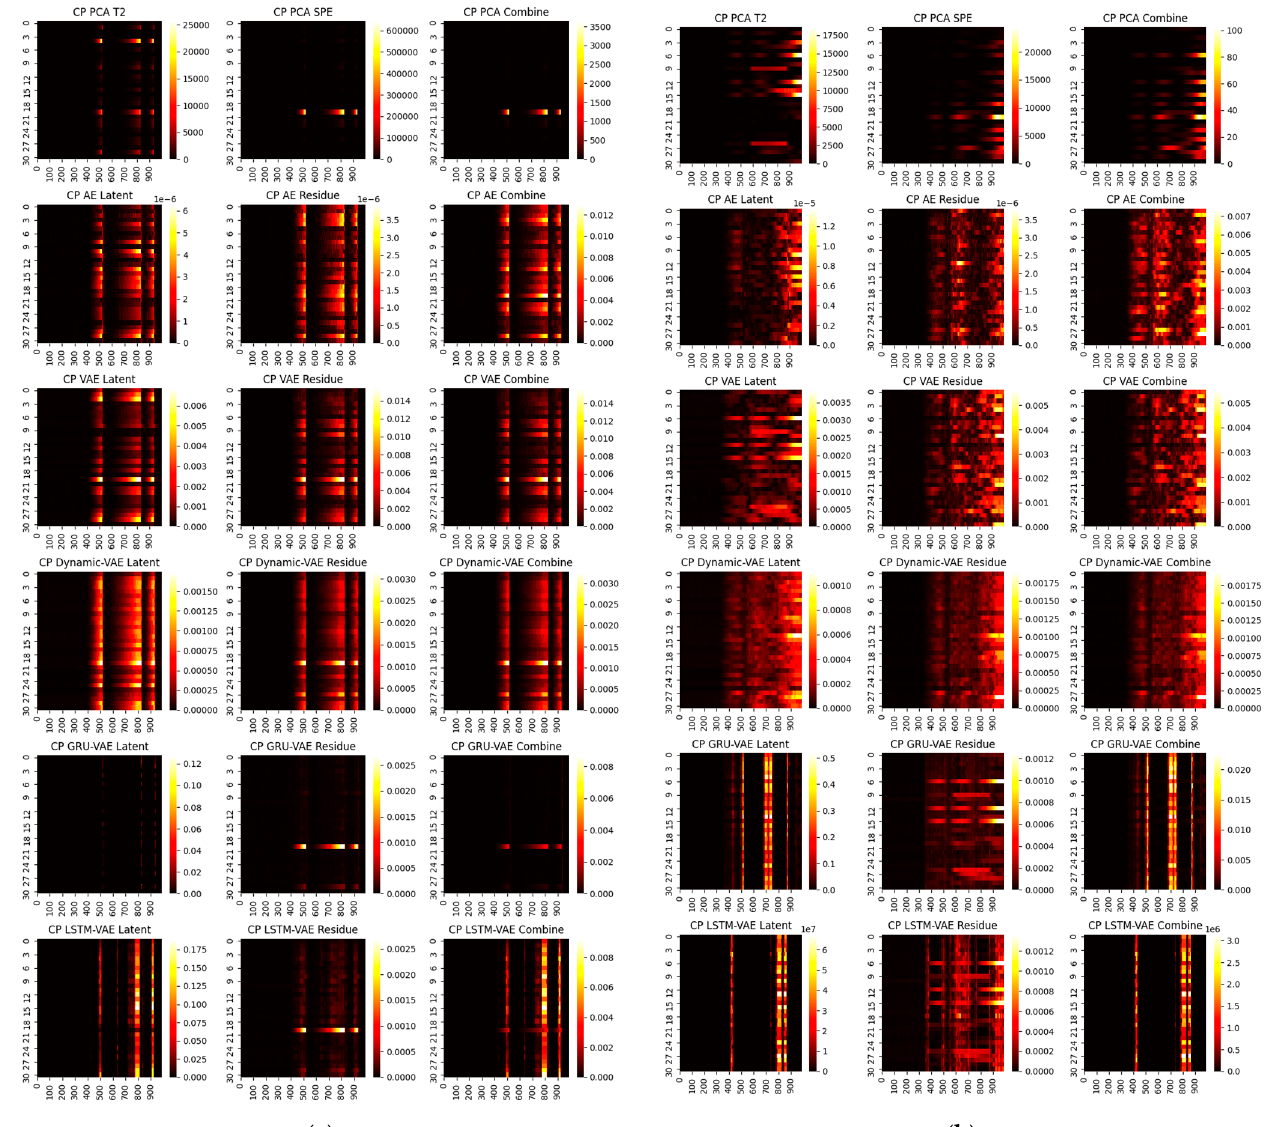
Figure 7. CP contribution plots for large faults: ( a ) fault 17, ( b ) fault 13. One can infer from the CP plots (Figures 6 and 7) that several diagnosis plots actu- ally show large deviations from the fundamental truth. The PCA can usually obtain a meaningful diagnosis in the residual and combined domains, but may, more or less, have deviations against the truth plots in most faults due to the smearing effects. The deep models have a similar issue, and one can speculate that the noisy gradients may even severely overwhelm those informative gradient flows from the responsible fault nodes during the back-propagation. Fortunately, as can be seen, such a noisy gradient problem in deep models can be largely alleviated by using the devised RBC scheme. The deep reconstruction is an enhanced implementation for contribution analysis with iterative opti- mizations. Specifically, one can judge from Figures 8 and 9 that significant improvements are found in all domains. Typically, the fault magnitude can be well determined once the detection indicator has been pulled close to the threshold. Please note that the estimation speed and accuracy are highly associated with both the model and the underlying fault magnitude. To make the investigation, we use the combined domain as the example, and the RBC contribution plots over various optimization epochs have been given in Figure